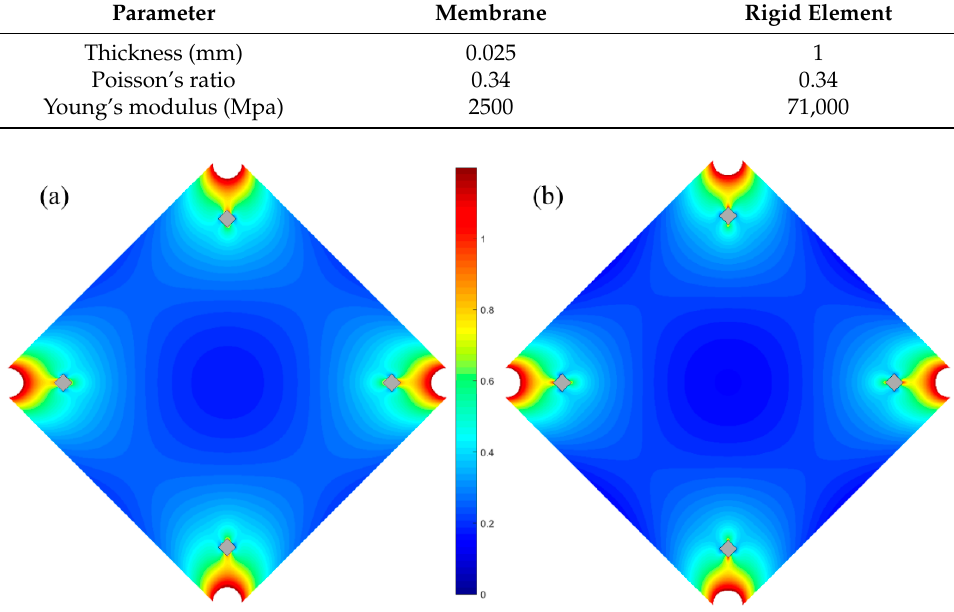
Table 1. Material parameters of membrane and rigid elements.